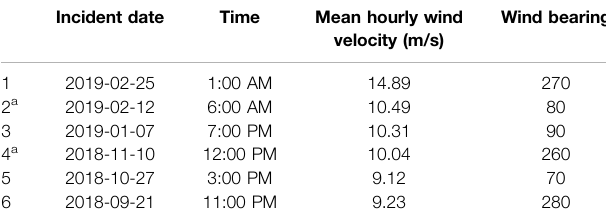
TABLE 2 | Maximum hourly wind speeds (2018 – 2019).